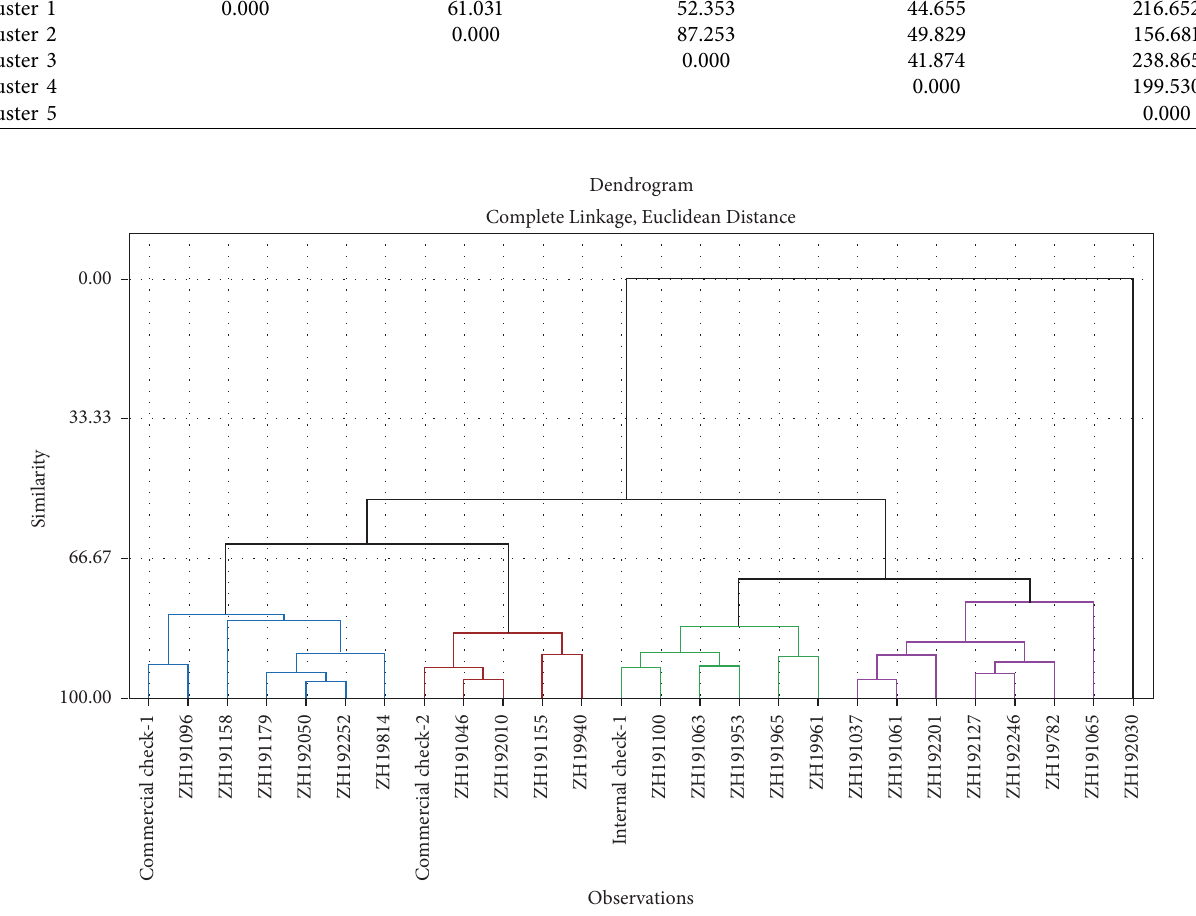
Figure 4: Cluster analysis of 26